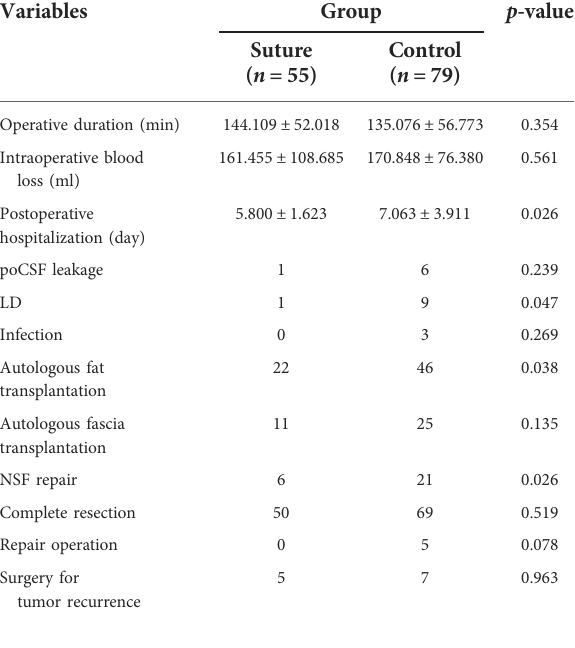
TABLE 2 Comparison of surgical effect with and without dural